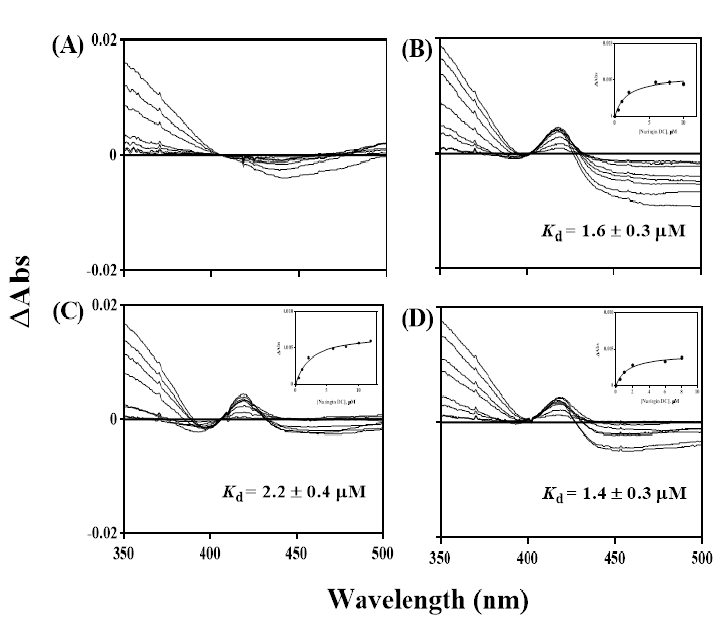
Figure 9. Binding titration of naringin DC to CYP102A1. The assay contained 0–20 µM naringin DC substrate in 100 mM potassium phosphate buffer (7.4) and 1.0 µM of M16V2 ( A ), G1 ( B ), M179 ( C ), and M221 ( D ). The inset of each panel ( B – D ) shows a plot of induced Soret absorbance change ( ∆ A390–420 ) versus the relevant concentration of naringin DC. Spectrally determined dissociation constants ( K d ) were also shown.